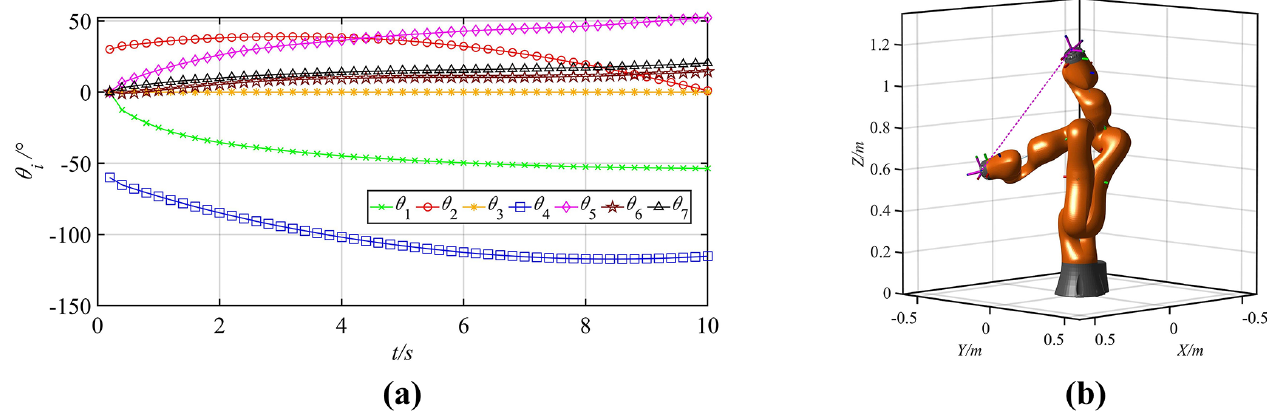
Figure 18. Motion curves of the joints and the manipulator ( k 3 = 0, k 1 = k 2 = k 4 = k 5 = k 6 = k 7 = 1 . 0). (a) Joint motion curves. (b) Tra- jectory of the manipulator.